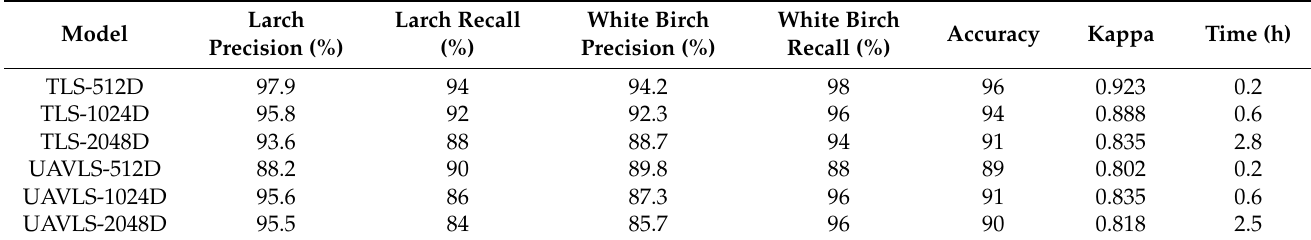
Table 6. Accuracy evaluation coefficient and calculation time of each